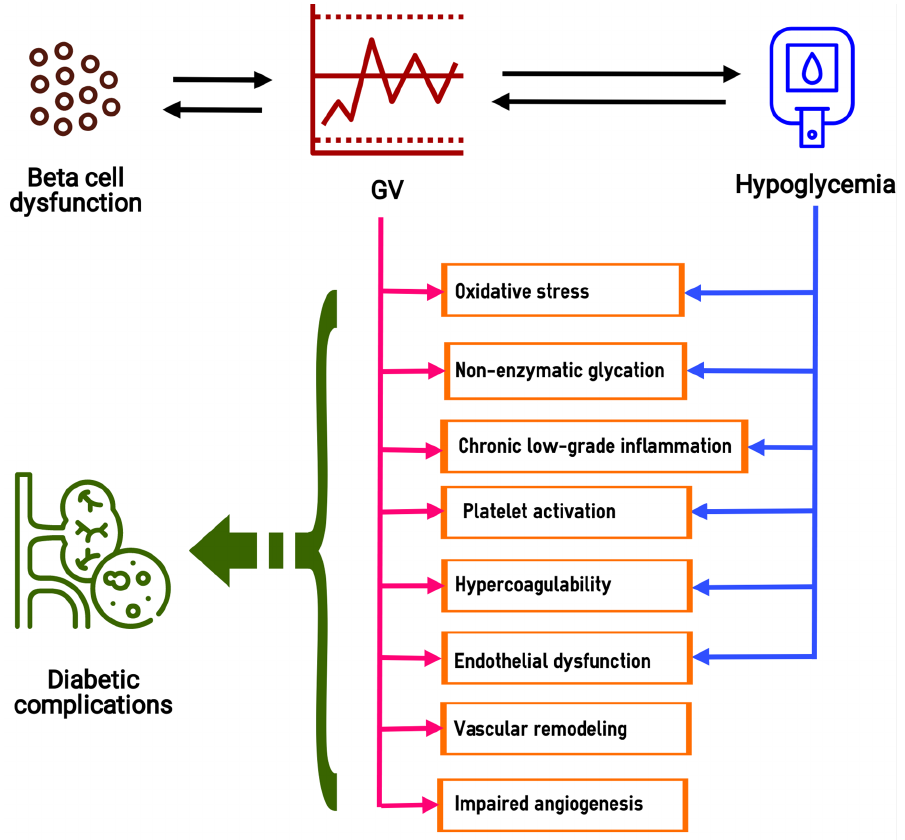
Figure 1. GV-related biochemical and pathophysiological abnormalities in the pathogenesis of diabetes complications. GV, glucose variability. The dotted lines in the GV block illustrate the excessive glucose oscillations. The green dashed arrow shows supposed relationships between pathophysiological processes, induced by high GV and hypoglycemia, and diabetic complications.